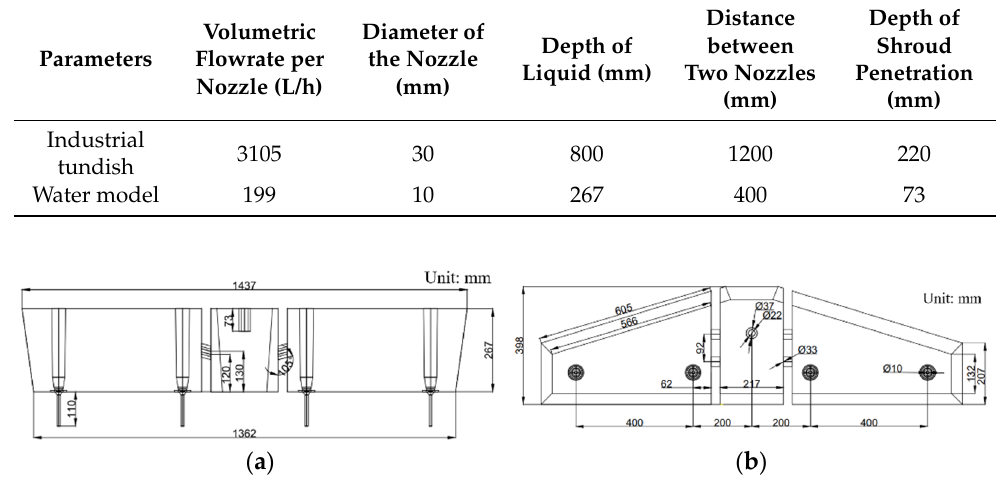
Figure 1. Two-dimensional drawing of double weir and four-strand tundish, ( a ) front view, ( b ) top view.